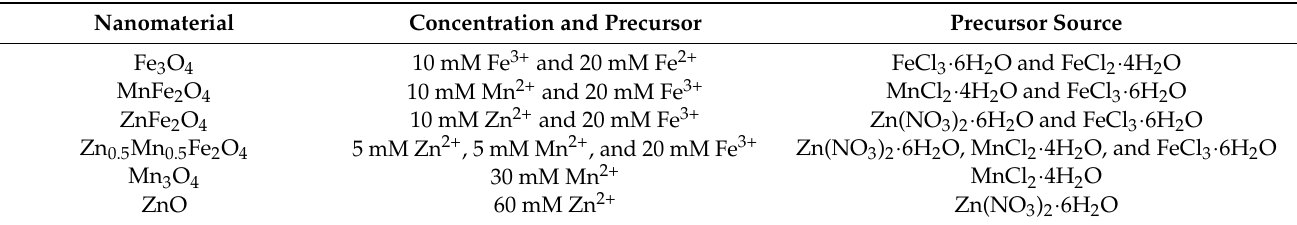
Table 1. Nanomaterial precursor concentrations and